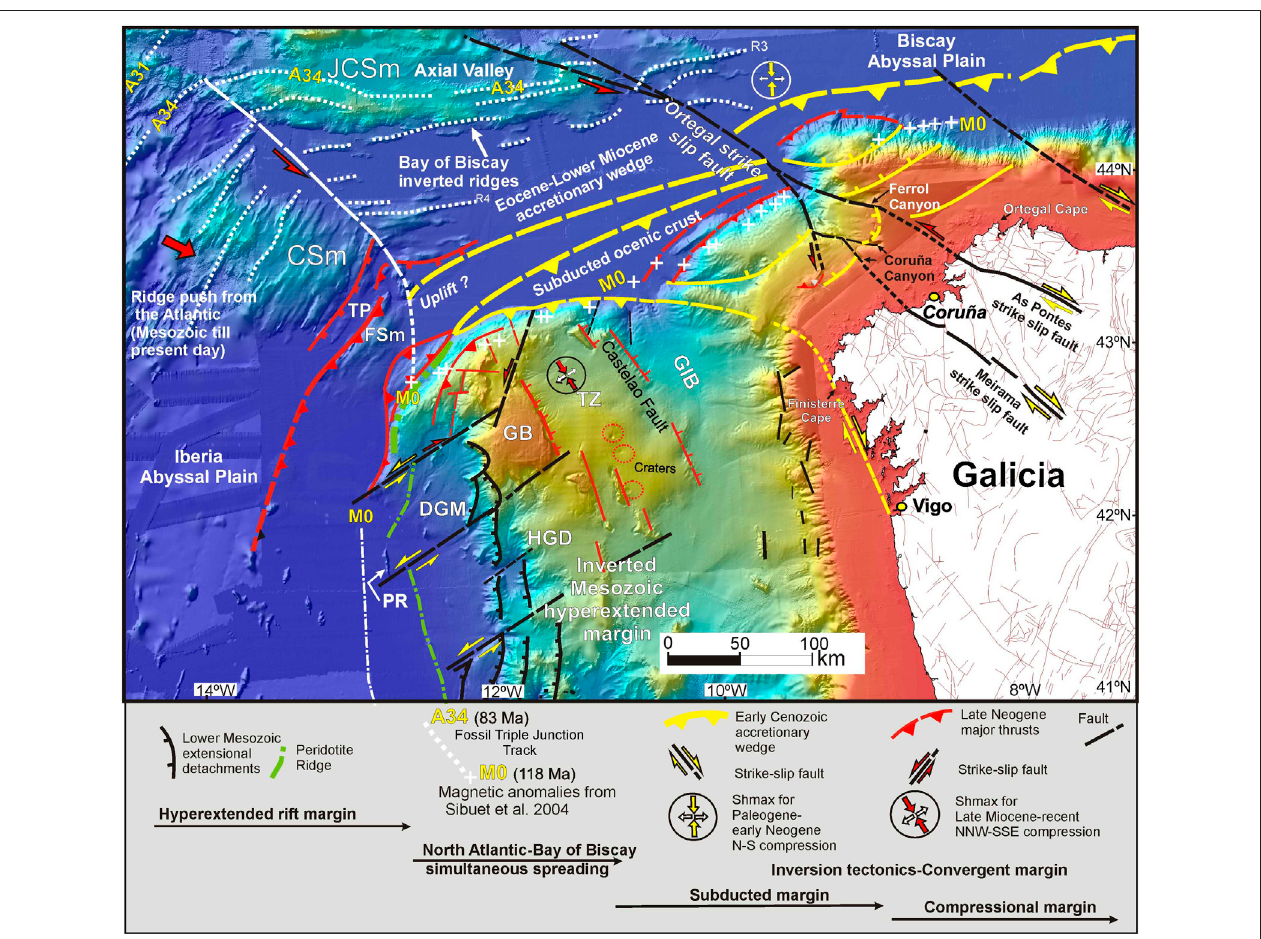
FIGURE9| Structure map ofthe Galicia margin showingthe mainAlpine-Pyrenes structures alongNorth Iberiasubduction margin (yellow lines)astheburiedfront of the accretionary wedge segmented by NW-SE large right-lateral strike-slip faults. CSm: Coruña Seamount; HGD, Half-Graben Domain; DGM: Deep Galicia Margin; FSm: Finisterre Seamount; GB:Galicia Bank; TZ, Transition Zone; GIB: Galicia Interior Basin; JSm: Jean Charcot Seamount; PR: Peridotite Ridge; TP:Theta Passage; MO: Magnetic anomaly MO.